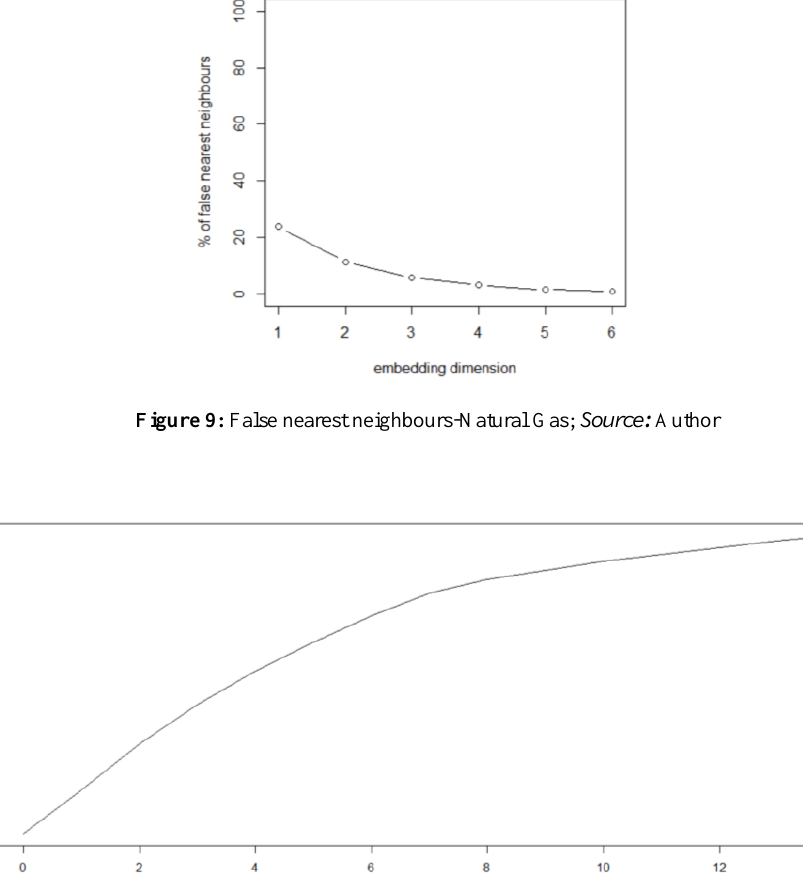
Figure 10: Average log distances and the iteration of initially nearby points -Crude Brent oil; Source: Author